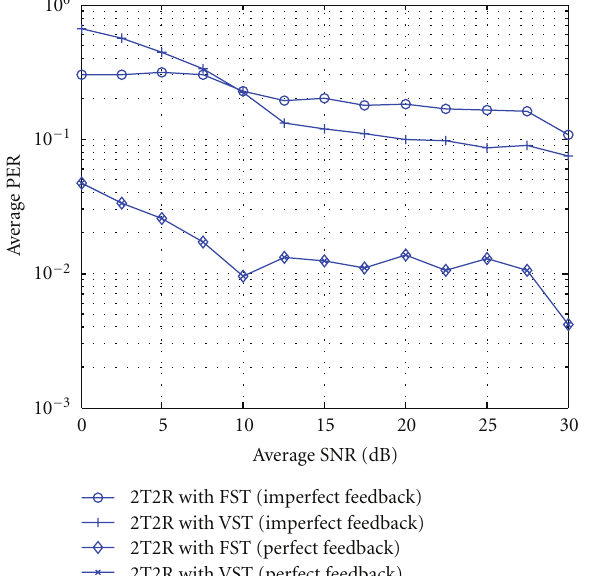
Figure 3: Average SE of CLD-AS with di ff erent transmit antennas and one receive